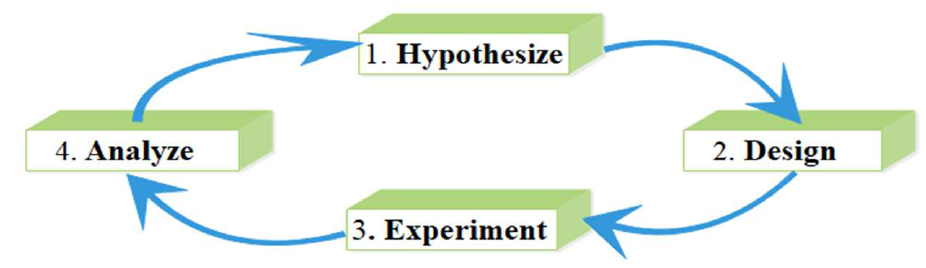
Figure 1. The iterative process of the scientific method [28].